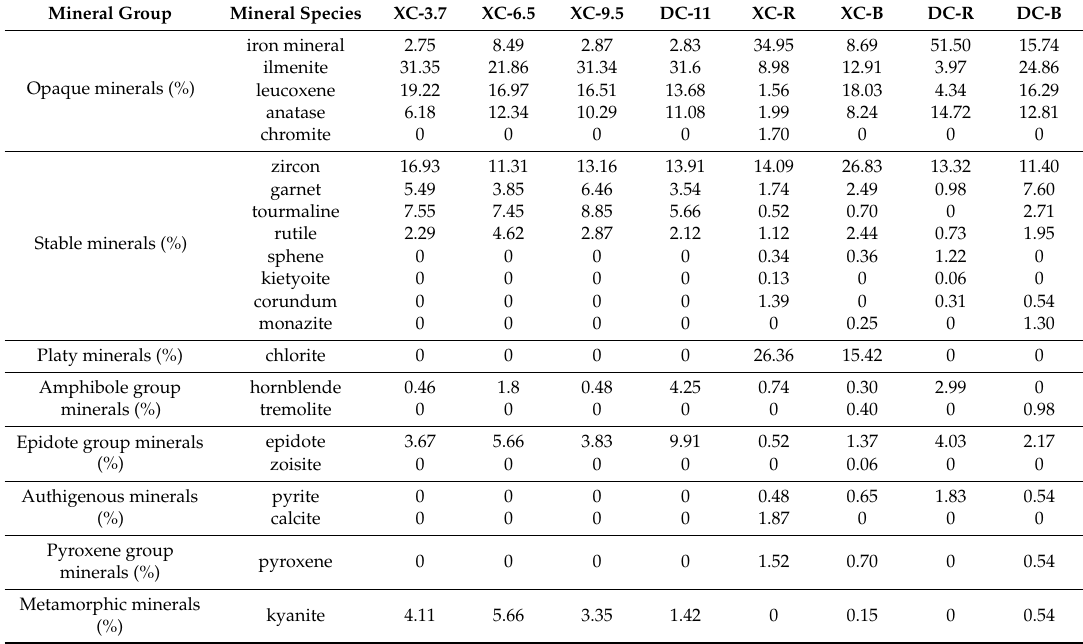
Table 3. Heavy minerals and percentages of sediment particles at Xichong and Dongchong.